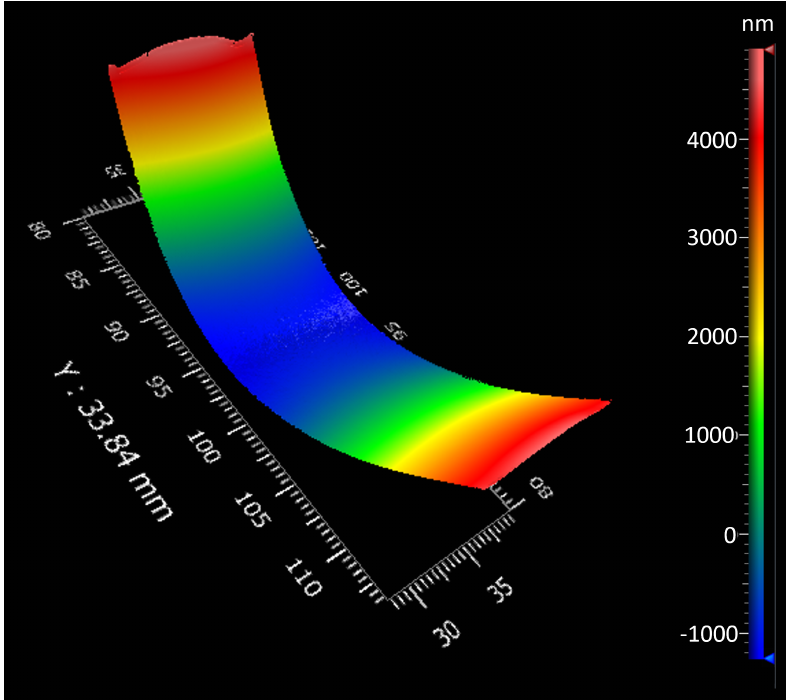
Figure 17. Surface profile reconstructed with nanometric precision by laser